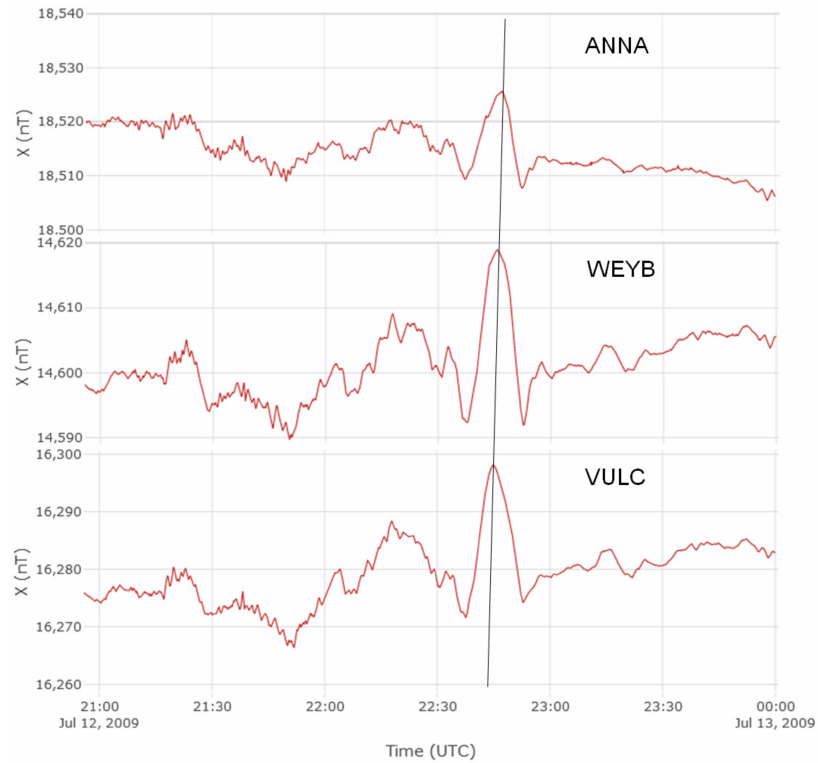
Figure 5. Variations of X-component of geomagnetic field observed by high-latitude magnetic stations at 21–24 UT on 12 July 2009. The peak times are connected by the black straight